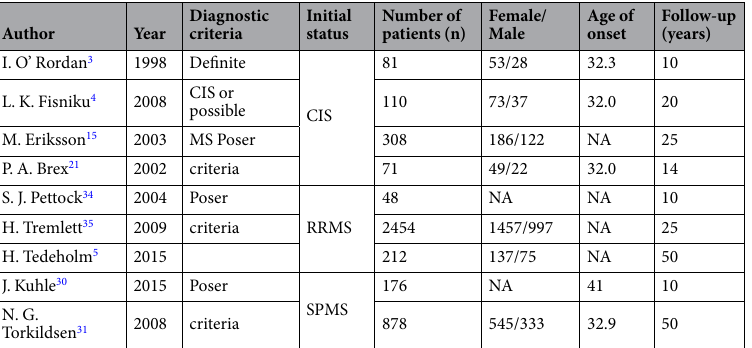
Table 1. Characteristics of the longitudinal follow-up studies included in the analysis. Initial status: the status of each patient cohort at the onset of longitudinal follow-up. CIS: clinically isolated syndrome; RRMS: relapsing- remitting multiple sclerosis; SPMS: secondary progressive multiple sclerosis. NA: not